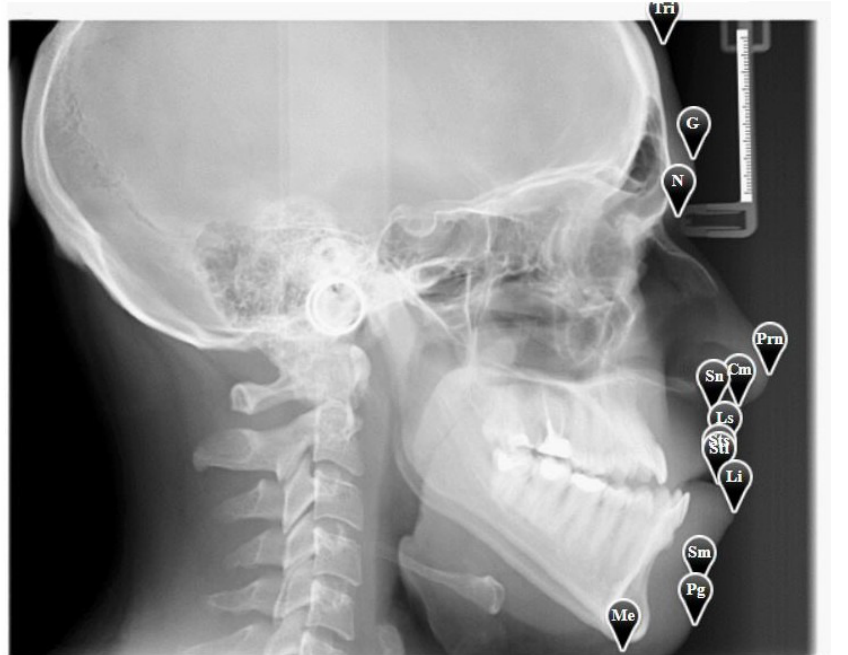
Figure 4. A sample X-ray image with